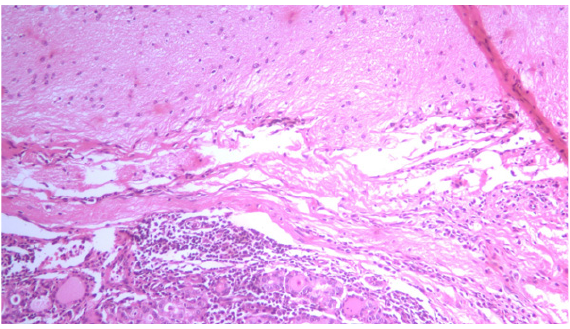
Figure 1. Mature Teratoma With the Area of Thyroid Tissue. Figure 2. Lymphocytic Thyroiditis With Lymphoid Follicle